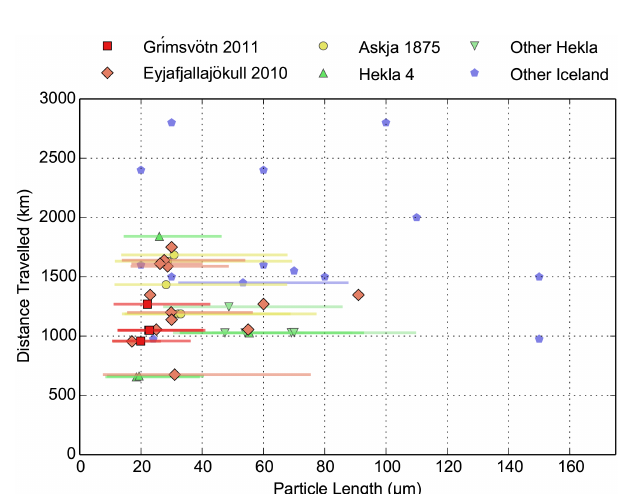
Figure 5. Diameter and travel distance of Icelandic cryptotephra in Europe. Both examples from the literature (Table 1) and those measured for this study (Table 2) are plotted. Horizontal coloured bars extend from the 10th to the 90th percentiles of the